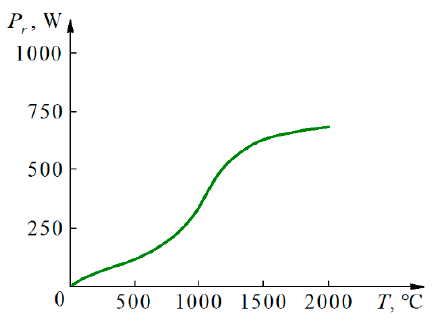
Figure 6. WC sintering power consumption P r versus temperature.